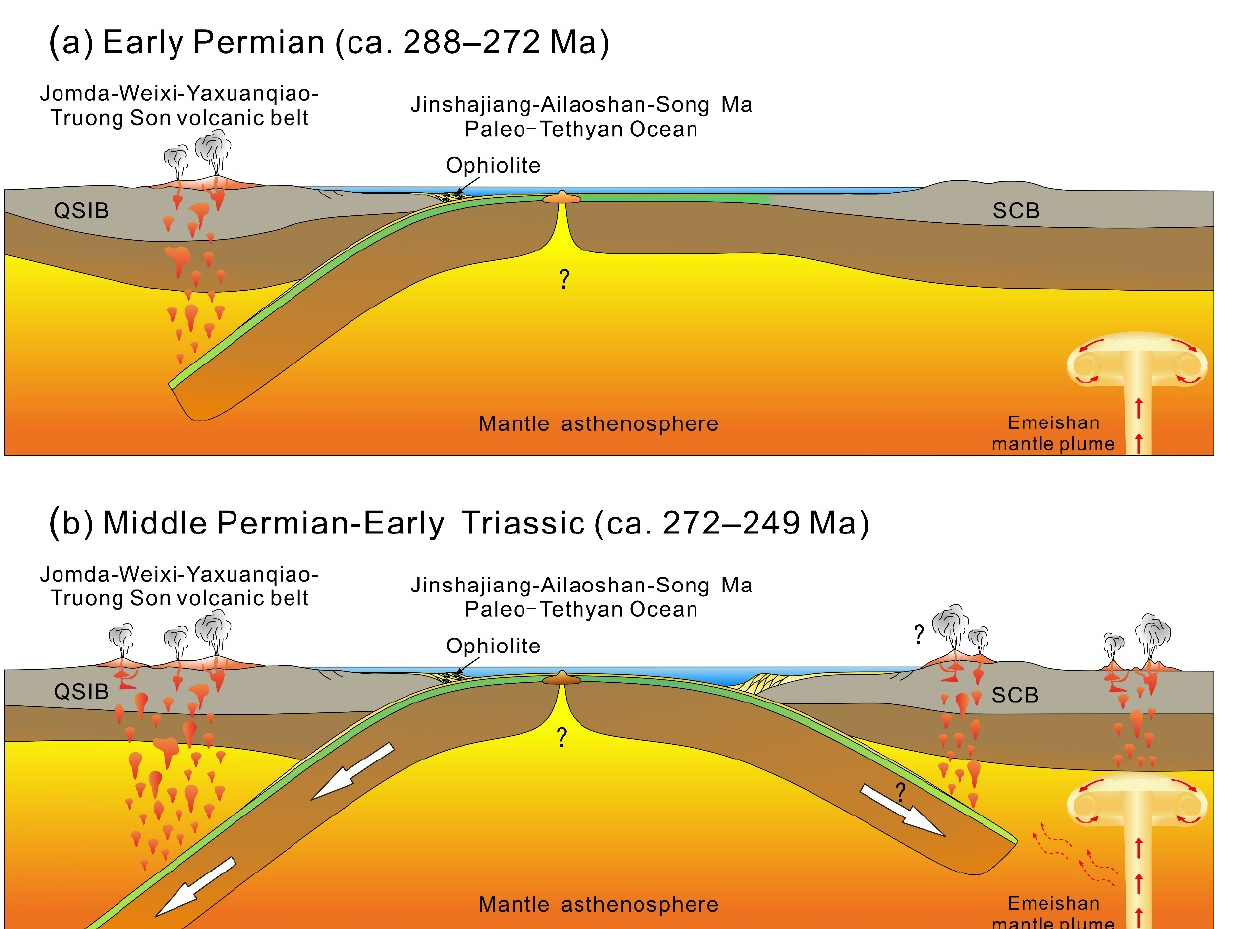
Figure 12. Schematic model illustrating the development of the JASB during the Early Permian to Late Triassic.( a ) During the Early Permian period (ca. 288–272 Ma), the JASO subducted westward under the QSIB and formed a continental margin arc along the JYTA; ( b ) During Middle Permian to Early Triassic (ca. 272–265 Ma), continuous subduction and slab rollback resulted in overriding plate extension to open a back-arc basin in the Batang-Yaxuanqiao area and to form Middle Permian MORB-like magmatic rocks. Meanwhile, subduction-associated magmatism that resulted from the eastward subduction of the JASO may have occurred on the southwestern margin of the SCB. ( c )